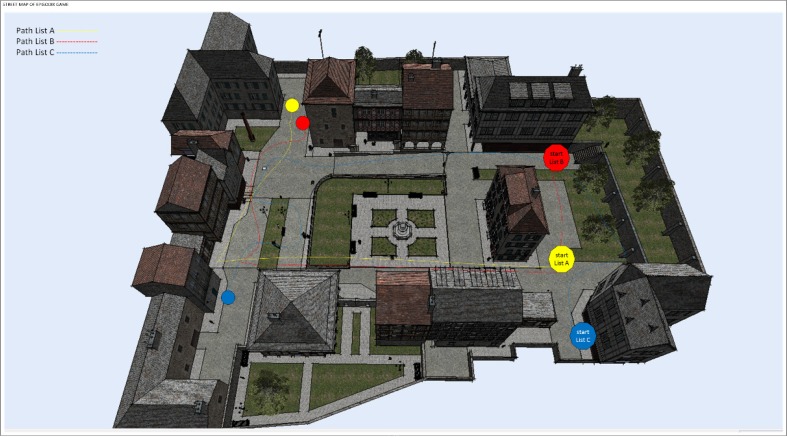
Street map of path lists in the Episodix digital game.